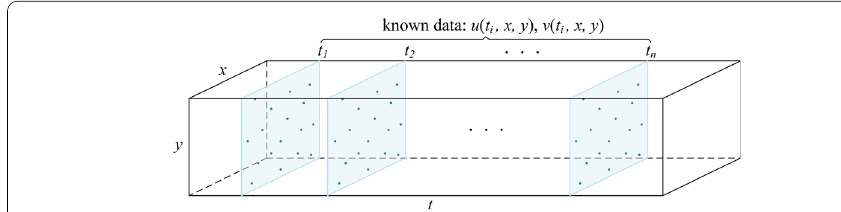
Fig. 2 Schematic diagram of temporal collocation of known data imposed to the PINN model